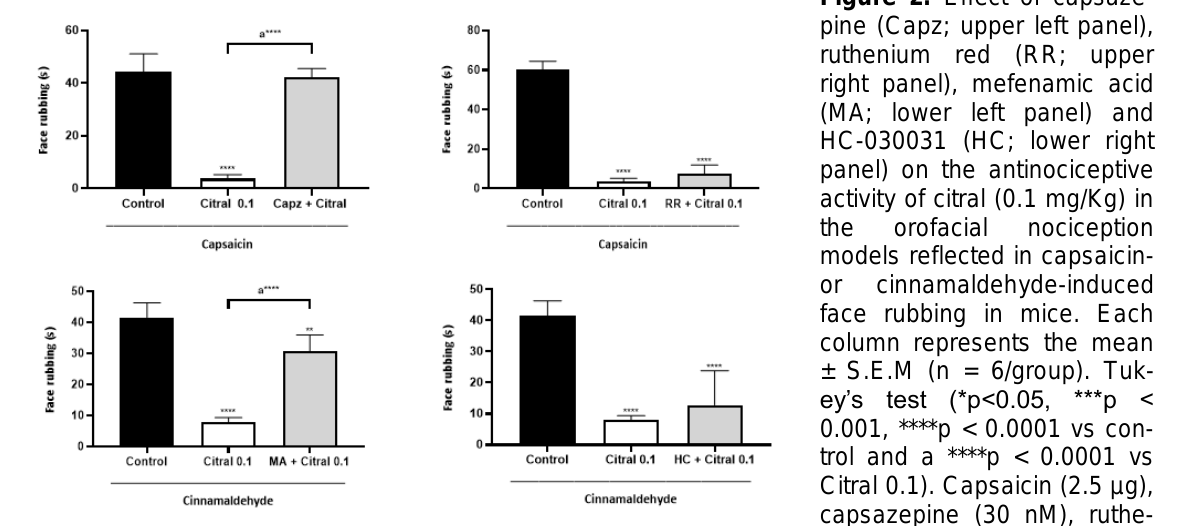
nium red (10 nM), cinnamaldehyde (0.66 µM), HC-030031 and (0.1 mg/mL) mefenamic acid (30 nM) were injected into the upper lip of animals 60 minutes after citral or vehicle (control) administration. Citral and vehicle (control) were administered by